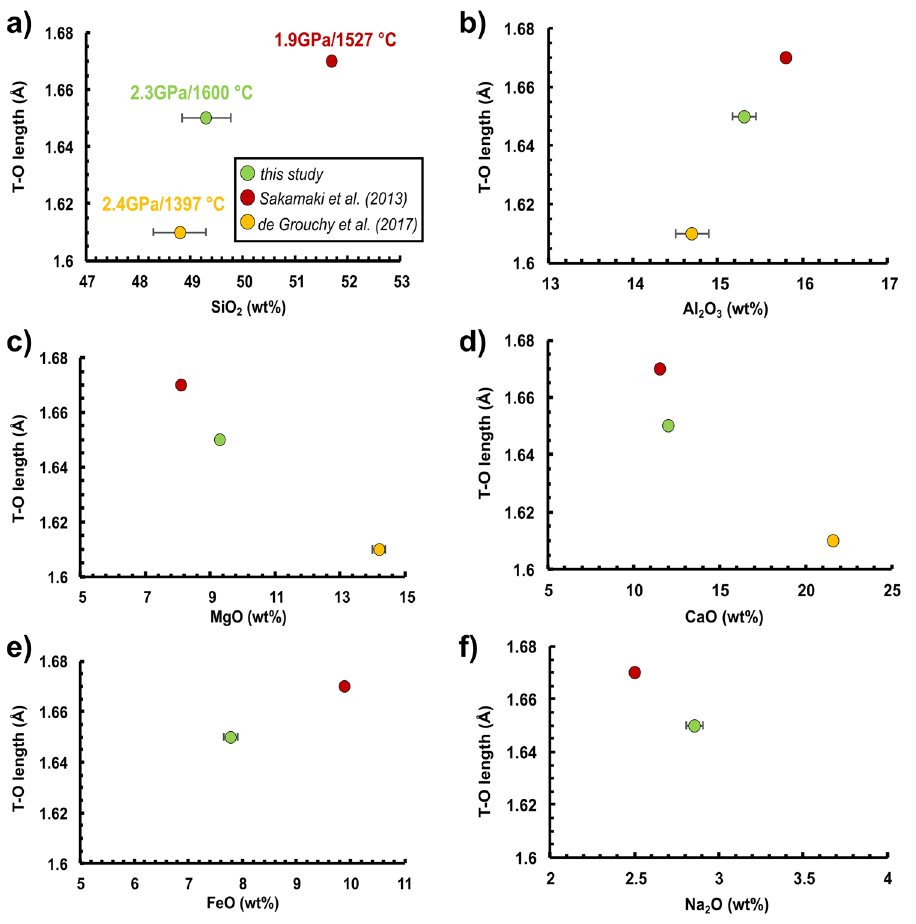
Figure 3. ( a – f ) Shown is the effect of major oxides on the T-O distance for APR16 compared with data from Sakamaki et al . 8 (MORB) and de Grouchy et al. 25 (AnD; anorthite-diopside composition) at ~ 2 GPa. Symbols are as in Fig.